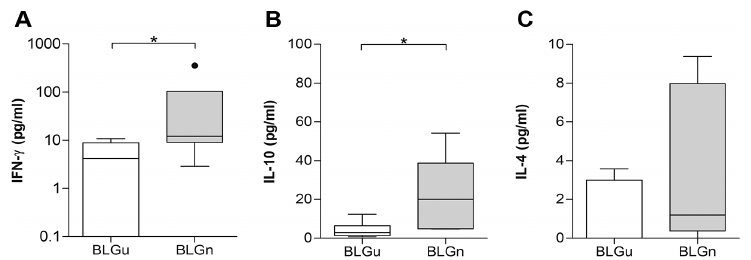
Figure 4. Re-stimulation of spleen cells with BLGu indicates the influence of treatment on cytokine production in non-allergic mice. Isolated spleen cells from non-allergic mice fed with BLGu or BLGn were stimulated with BLGu to evaluate the cytokine production upon allergen encounter. Baseline levels were subtracted. Spleen cells of BLGn-gavaged mice produced significantly higher levels of ( A ) IFN- γ (Mann–Whitney-U-test) and ( B ) IL-10 (unpaired t -test) compared to group BLGu. ( C ) IL-4